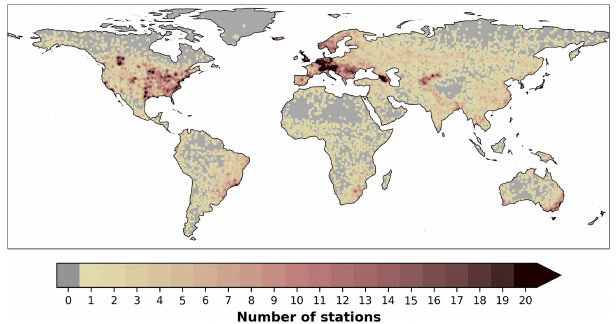
Figure A1. Sum of the temperature stations located in each grid cell and its eight neighboring grid cells. This map is used to mask out regions with no temperature observations. Data available at